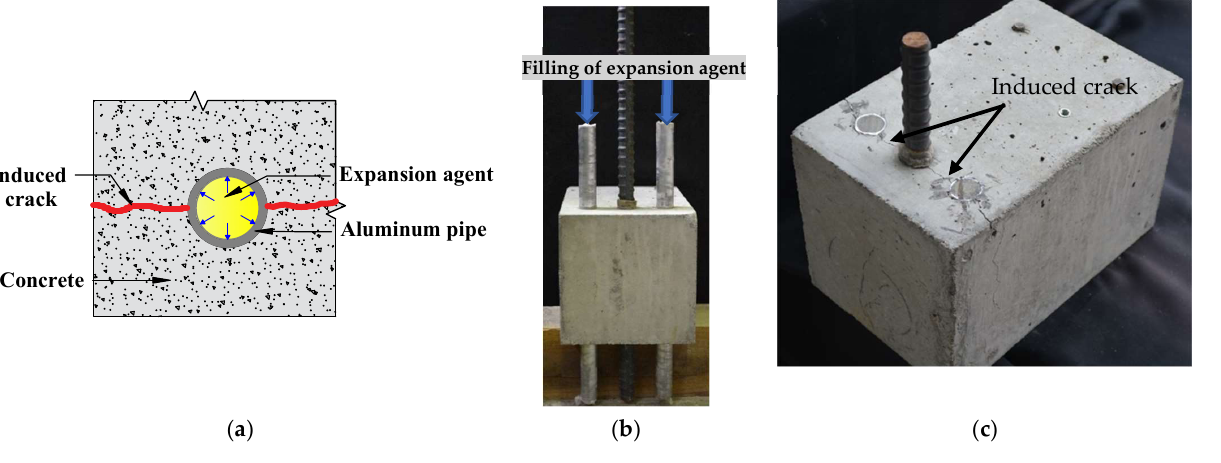
Figure 22. Cracking of concrete with EAFP: ( a ) cracking process; ( b ) filling with expansion; ( c ) example of cracking (adopted from Syll et al. [100]).